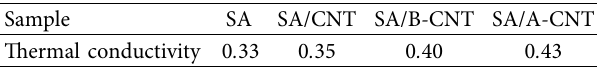
Table 1: Thermal conductivity of stearic acid and its composite phase change heat storage materials, unit: W/(m.K).